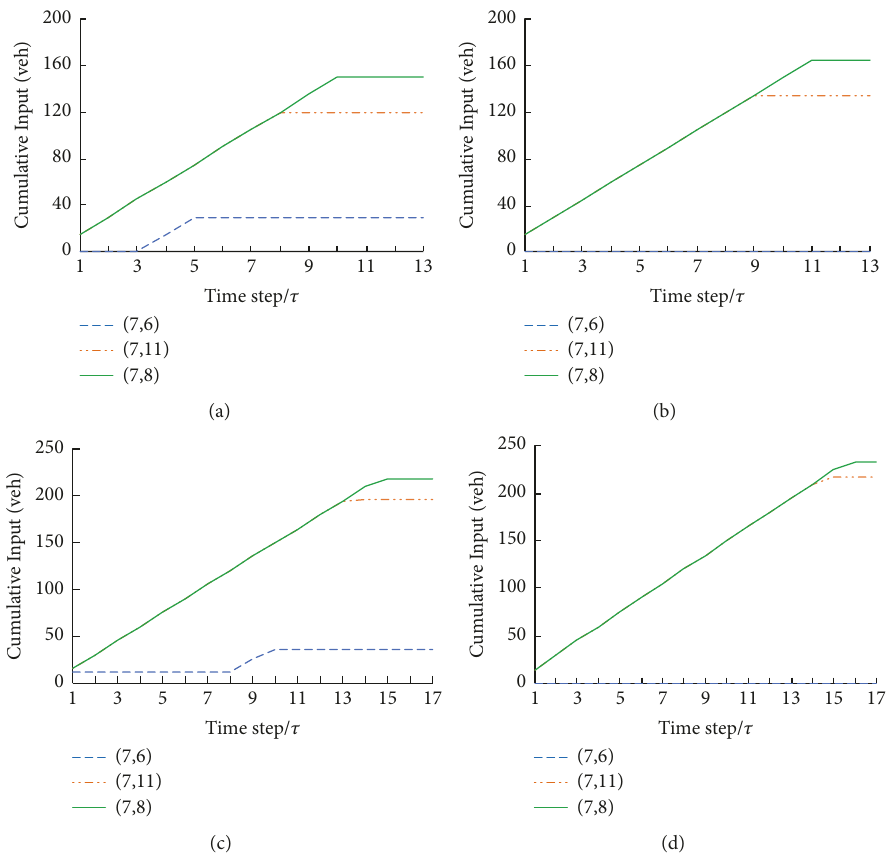
Figure 5: Cumulative persons evacuated into different roads from community o 3 under various evacuation situation: (a) traditional method, low demand; (b) improved method, low demand; (c) traditional method, high demand; (d) improved method, high demand.